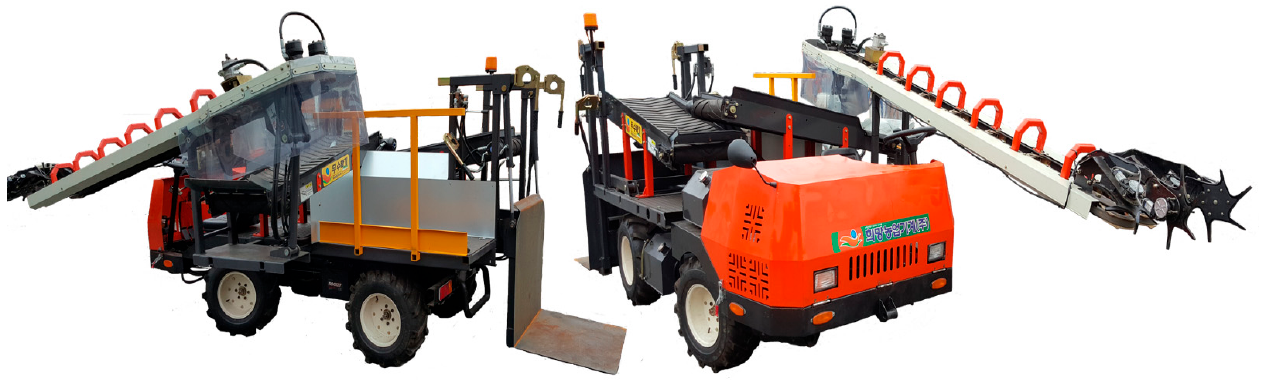
Table 1. The specifications of the radish harvester used in this study. Parameters